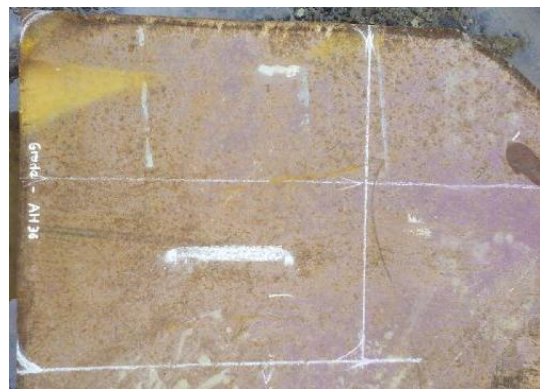
Figure 7: Repair material: steel grade